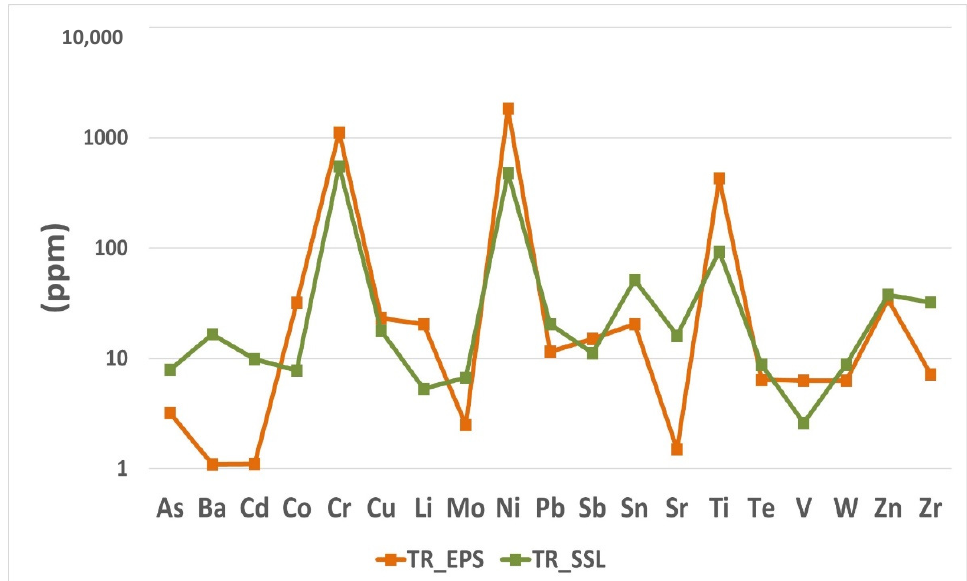
Figure 5. Comparison of trace elements concentration in tremolite asbestos from Episcopia (TR_EPS) and San Severino Lucano (TR_SSL) villages.